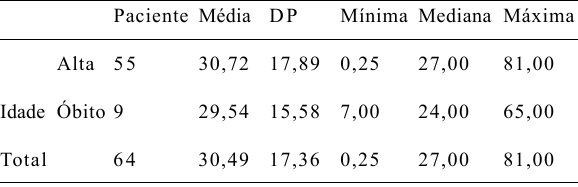
Tabela 3. Relação entre a idade e o óbito ou a alta hospitalar.